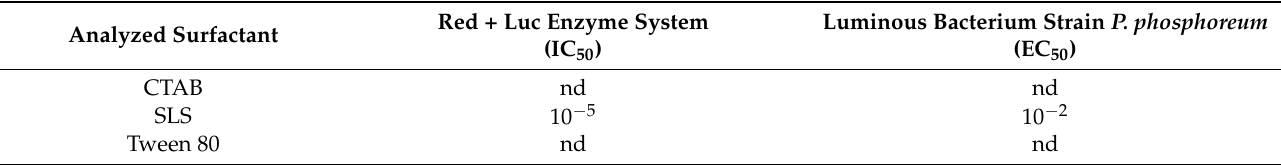
Table 1. The values of the parameters IC 50 and EC 50 for the Red + Luc enzyme system and luminous bacteria. The data are presented as the molar concentration (M). nd—not determined, low inhibition (%) at the maximum concentration